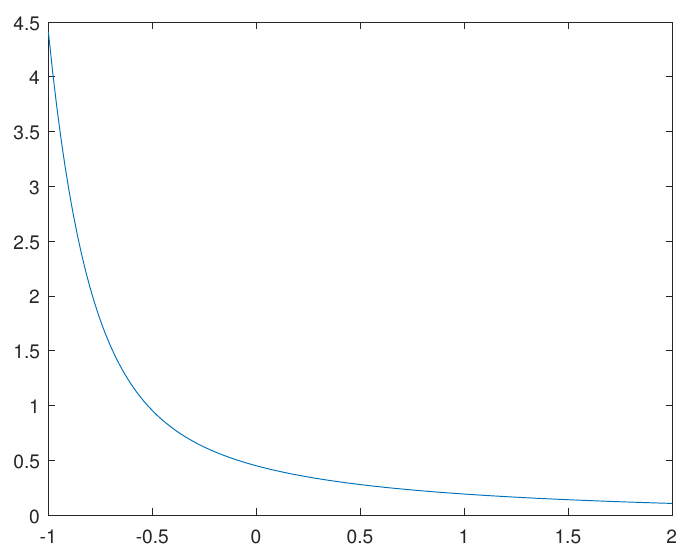
Figure 2. Mellin Transform of M ( x ) defined on [ − 0.98,2 ]